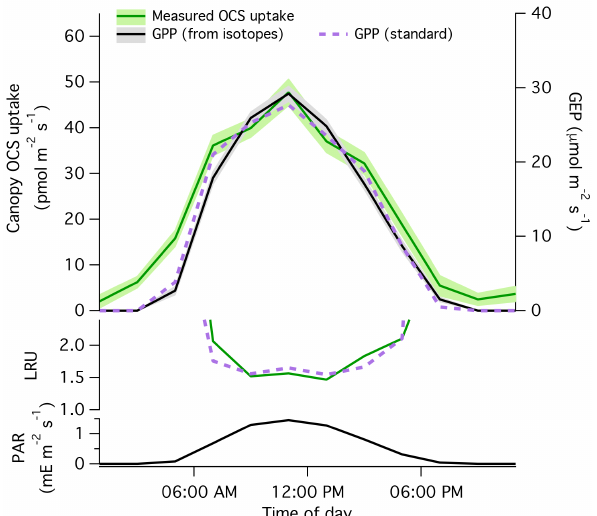
Figure 5. Composite diel cycles (including May through October of 2012 and 2013) of canopy OCS uptake and GPP, along with LRU and PAR. GPP from the isotopic and standard partitioning meth- ods described in Wehr et al. (2016) are shown. Lines connect the mean values of each 2h bin. Pale bands depict standard errors in the means as estimated from the variability within each bin.